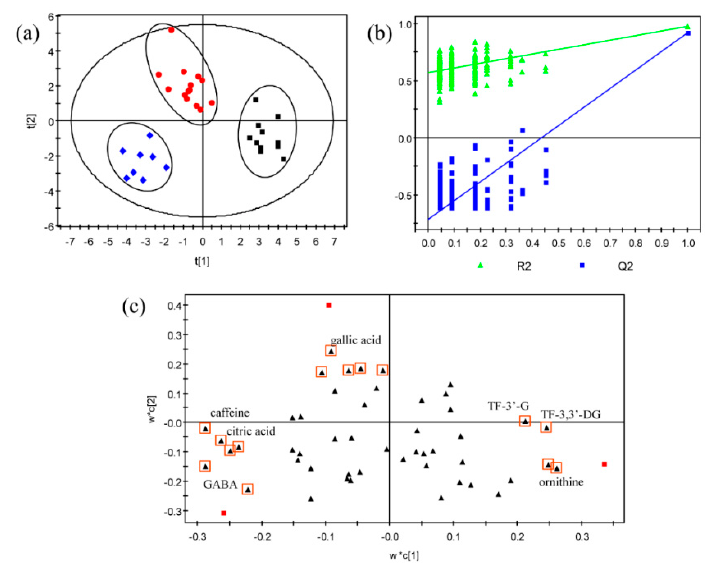
Figure 1. An overview of the chemical composition profiles of black tea infusions featured with the sweet-mellow, mellow-pure, and less-mellow taste quality revealed by partial least square–discriminate analysis (PLS-DA) after orthogonal signal correction (OSC) data filtering. ( a ) Score scatter plot of tea infusion profile composed of quantified taste-active compounds after unit variance (uv) scaling. Black box, red dot, and blue squares represent tea infusions rendering the sweet-mellow, mellow-pure, and less-mellow taste quality, respectively. ( b ) Cross-validation of the PLS–DA model by 200 permutations. ( c ) Loading plot. Black triangles represent all variables and those highlighted with red box indicate compounds that might significantly contribute to group separation. TF-3 ′ -G, theaflavin-3 ′ -gallate; TF-3,3 ′ -DG, theaflavin-3,3 ′ -digallate; GABA, γ -aminobutyric acid. Furthermore, all quantified tastants were statistically compared (Table 2).